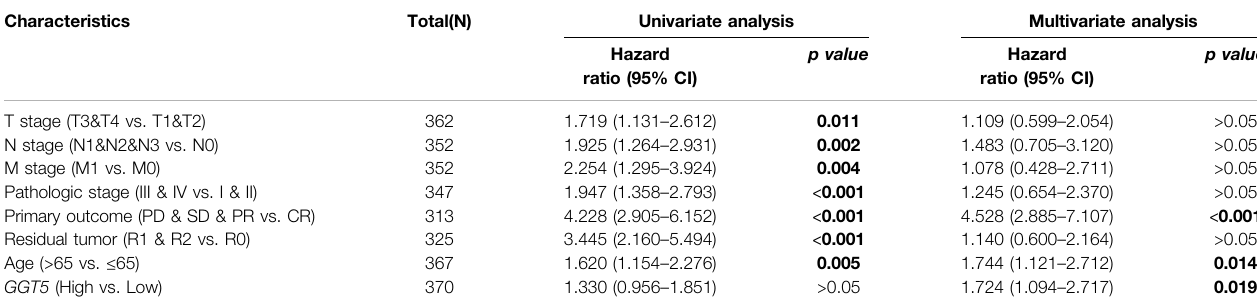
TABLE 3 | Univariate and multivariate Cox regression analysis of the risk factors for OS in patients with gastric cancer. Characteristics Total(N) Univariate